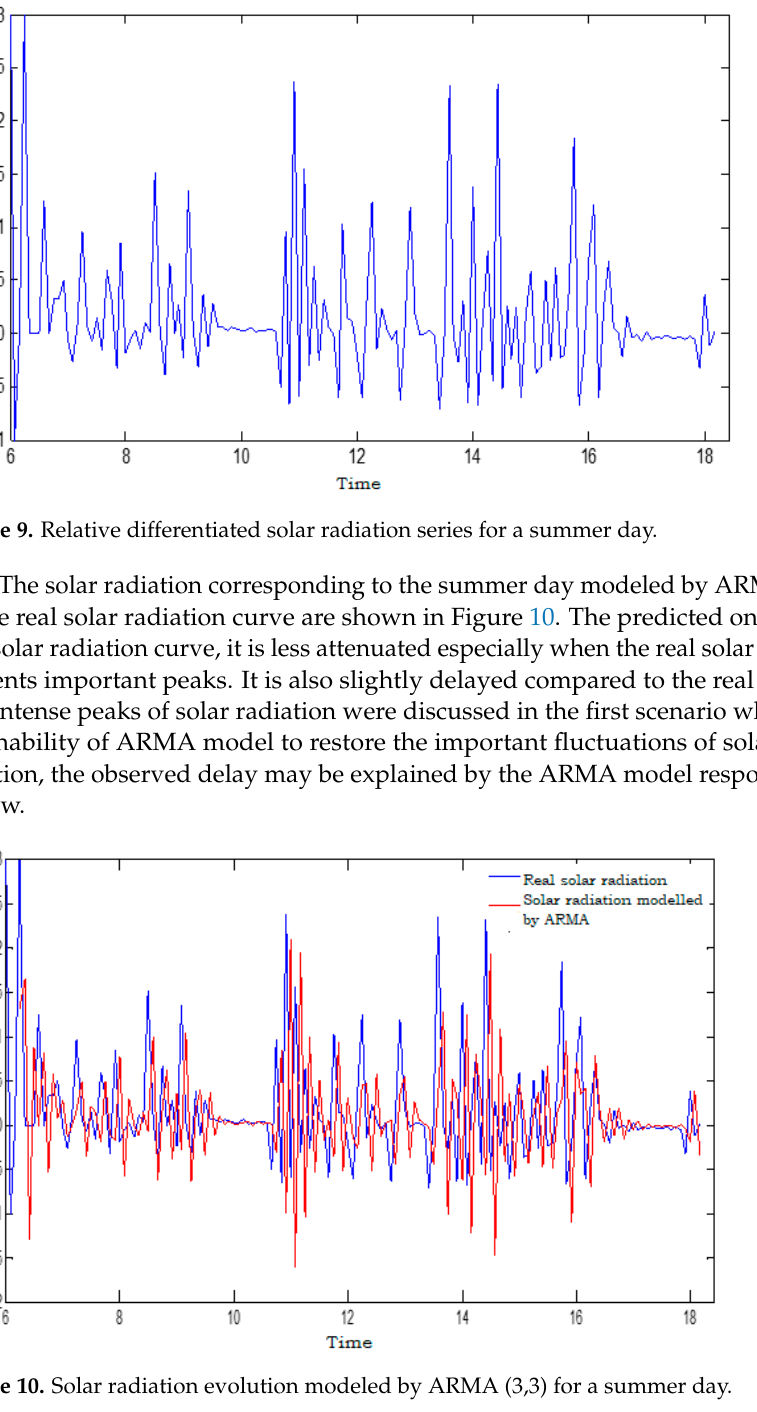
( b ) Figure 11. ( a ) Error and ( b ) relative error of solar radiation modeled by ARMA (3,3) (for a summer day). Table 5. MSE, MAE, and RMSE of the prediction of solar radiation using ARMA (3,3) (summer day). Errors Values MSE 0.8678 MAE 0.6418 RMSE